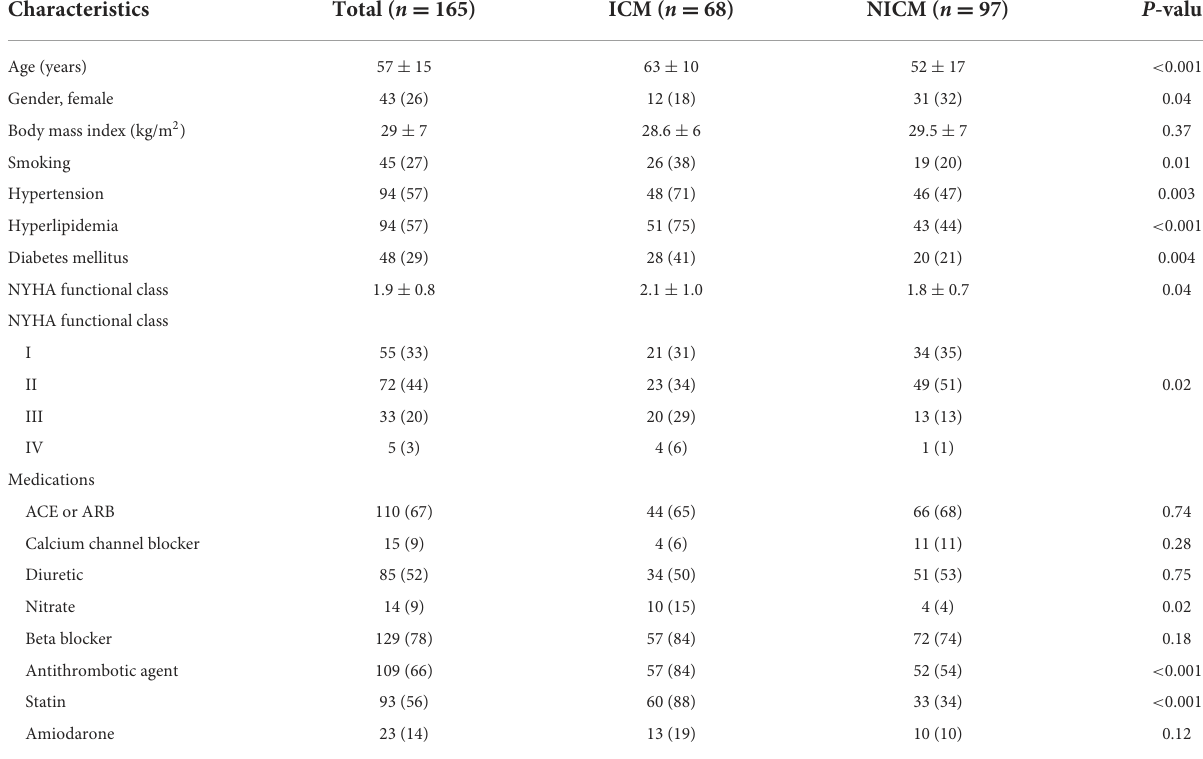
TABLE 1 Baseline characteristics of the